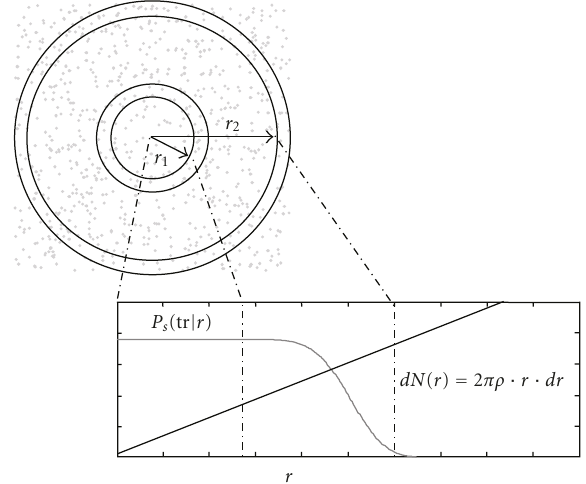
Figure 2: The neighbors are considered placed in rings centered at the transmitter. The mean number of successful hops of length r results from the product of the success probability (gray line) having γ ( r ), and the number of nodes (black line) in a di ff erential ring of thickness dr and radius r